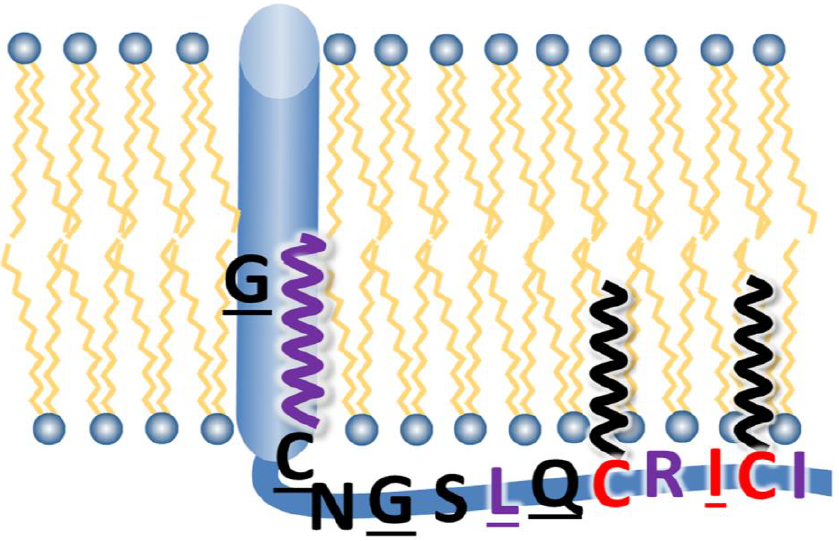
Figure 6. Model of the cytoplasmic tail of HA. Amino acids, indicated in single letter code, which were exchanged in this study, are underlined. Essential amino acids, i.e. , the non-conservative substitution of which prevented rescue of infectious virus particles, are in red . Fatty acids attached to CT and TMD cysteine residues are depicted by a black (palmitate) or purple (stearate) zigzag line. Hydrophobic or positively charged amino acids that probably interact with the acyl chains or head groups of (negatively charged) lipids are in purple.